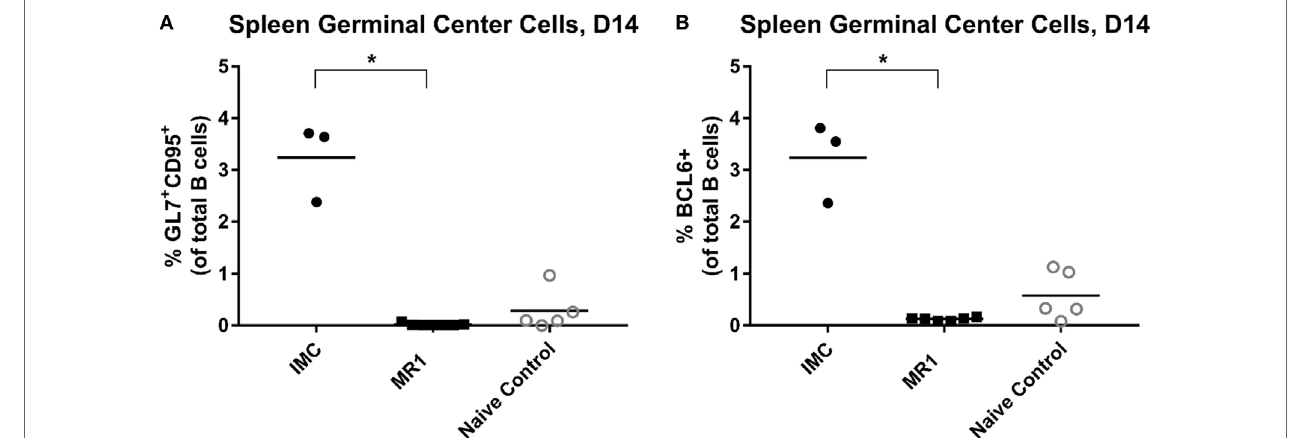
FigUre 5 | CD40/CD40L blockade prevents germinal center formation after HOD (hen egg lysozyme, ovalbumin, and human duffy b ) transfusion. (a) Splenic germinal centers (GL7 + CD95 + B-cells) or (B) BCL6 + B-cells cells, 14 days after primary HOD RBC exposure. * p < 0.05 by ANOVA. Data are representative of two experiments ( n = 3–6 mice per group per